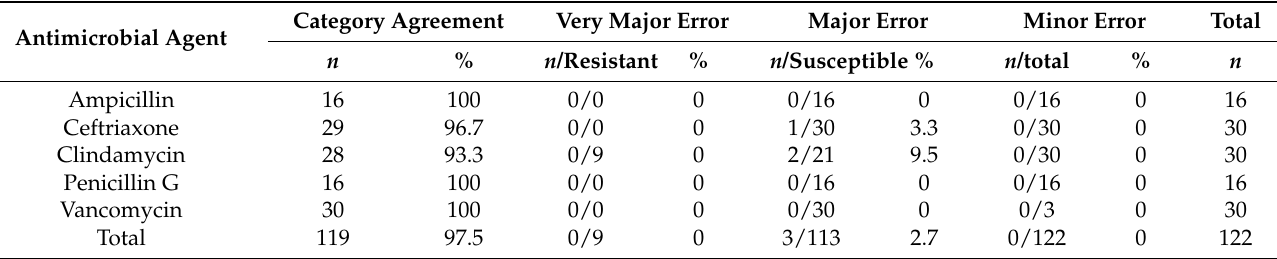
Table 5. High category agreements for the antimicrobial agent selection were identified in Gram-negative bacteria which were examined by the short-term (3.5 h) incubation with the BD Phoenix M50 AST system 1 . Category Agreement Very Major Error Major Error Minor Error Total Antimicrobial Agent n % n /Resistant